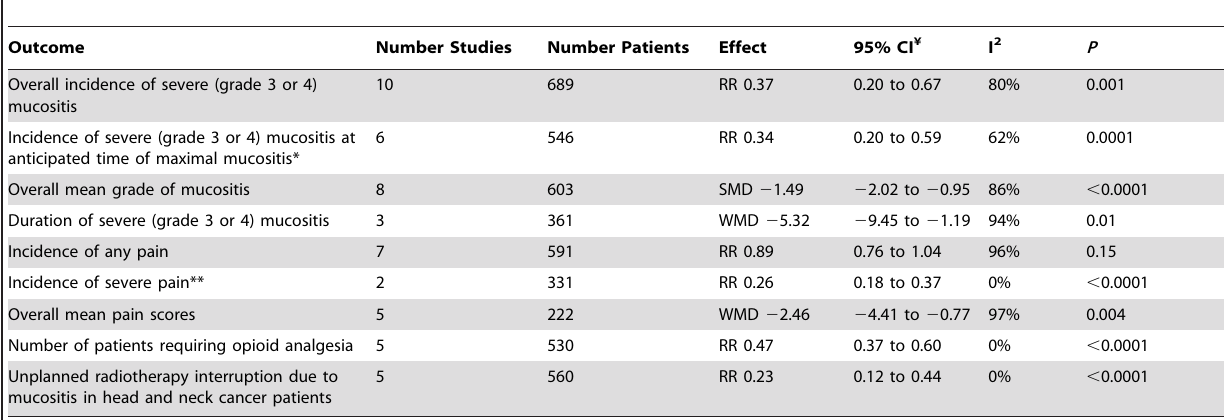
Table 2. Summary of outcomes of low level laser therapy as compared to placebo/no treatment.